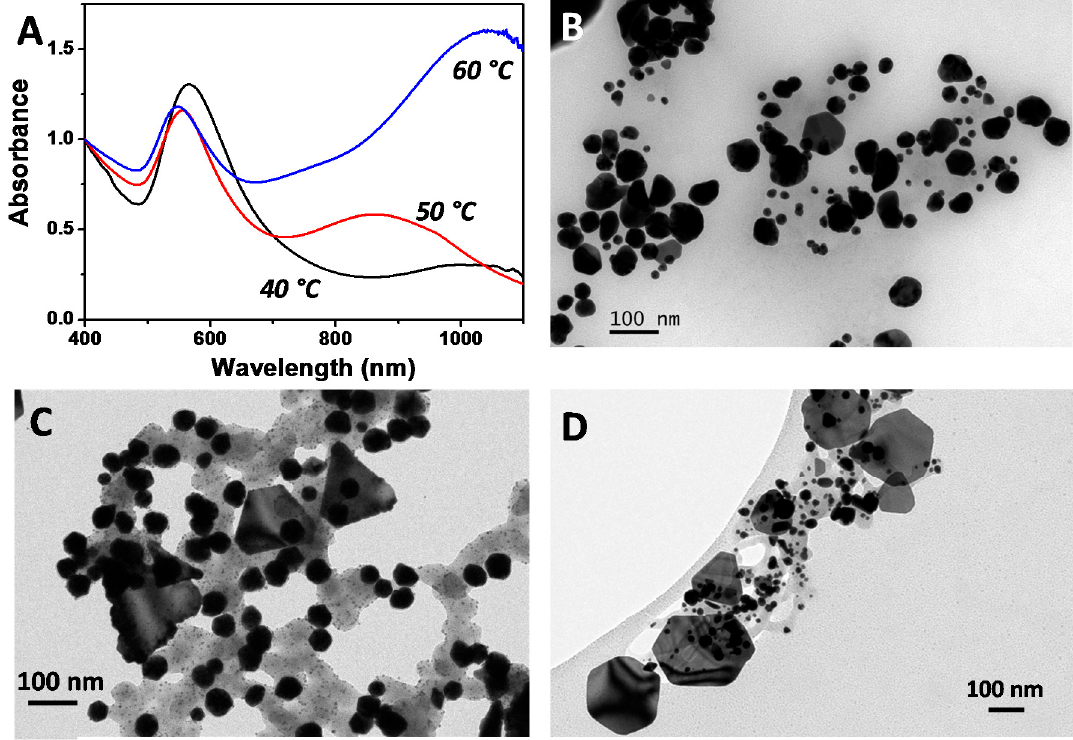
Figure 3. ( A ) Normalized Vis-NIR spectra of Au NPs obtained in the presence of the biosurfactant extracted from corn steep liquor at three different temperatures as indicated. ( B – D ) Representative TEM images of Au NPs obtained at 40 °C ( B ); 50 °C ( C ), and 60 °C ( D ).